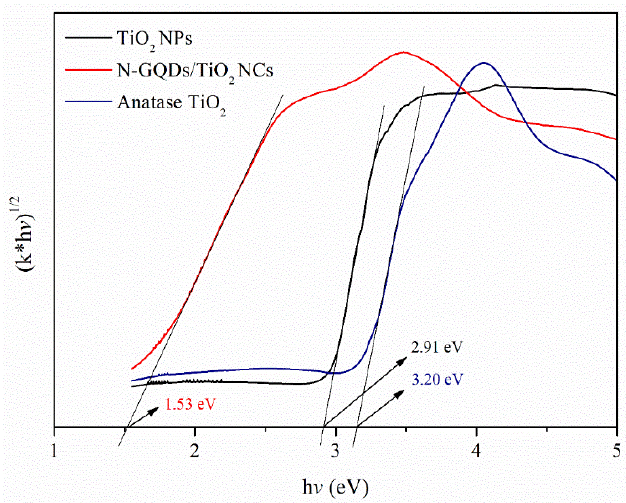
Figure 2. The bandgap of synthesized TiO 2 NPs, N-GQDs/TiO 2 NCs and anatase TiO 2 .